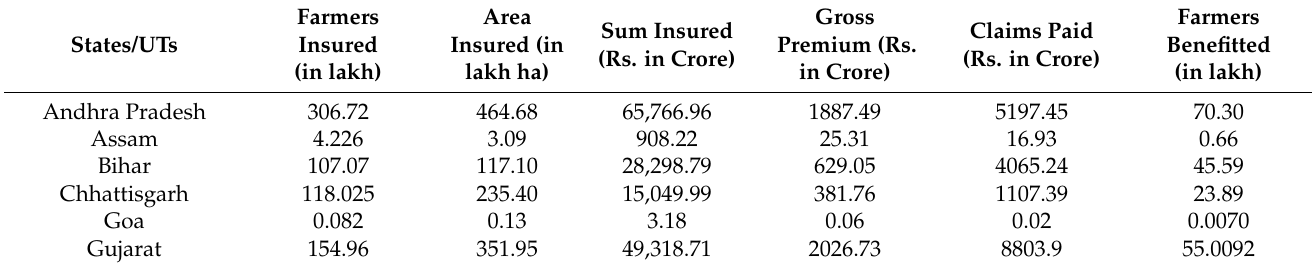
Table A1. State-wise cumulative performance of NAIS in India (rabi 1999–2000 to rabi